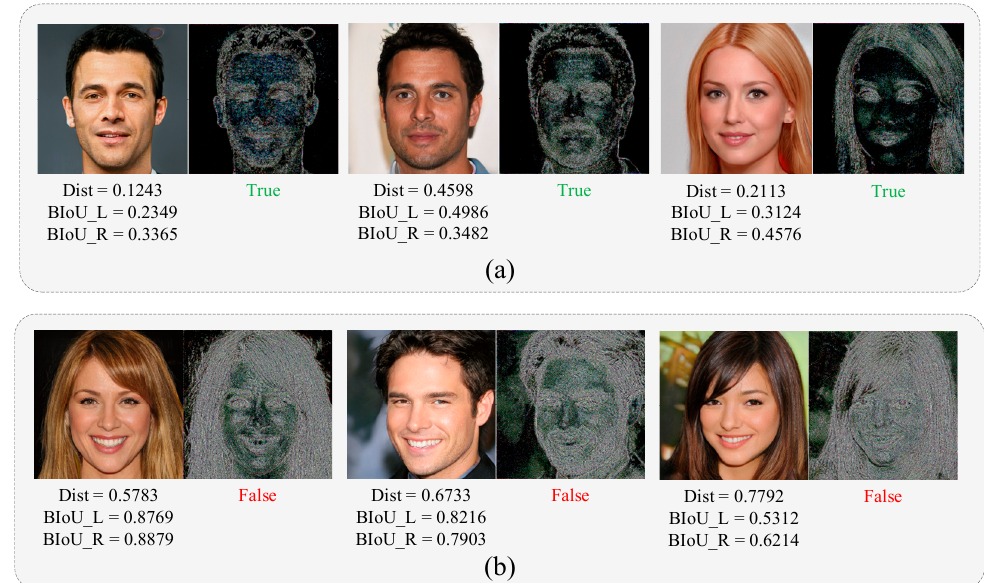
Figure 7. Example of complementary performances in two branches. ( a ) the image detected by the local branch. ( b ) the image detected by the global branch.